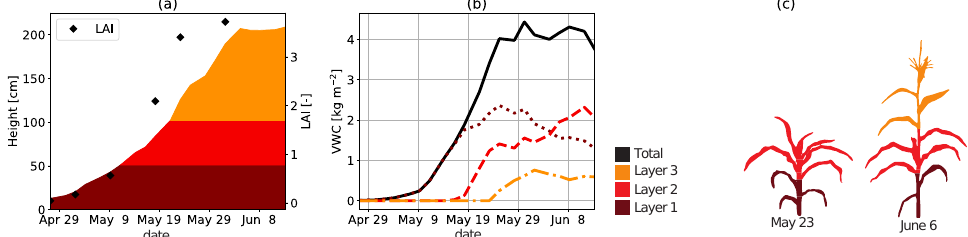
Figure 2. Canopy height divided into three layers including LAI ( a ); total plant VWC divided into three layers ( b ); and visualisations of the layer division in two different growth stages ( c